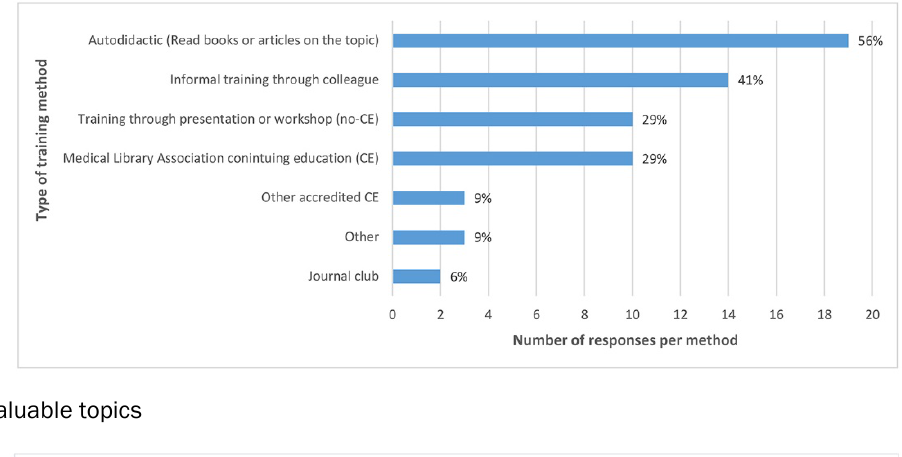
Figure 1 Prior evidence-based practice (EBP) training